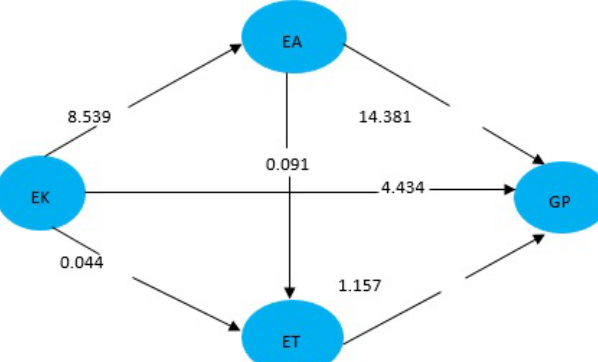
Fig. 2: Direct effects, structural model assessment. It mainly showed the t-value and path coefficient for accepting or rejecting the hypothesis Table 4: Structural model assesment (direct effect result and decision) Hypo thesis